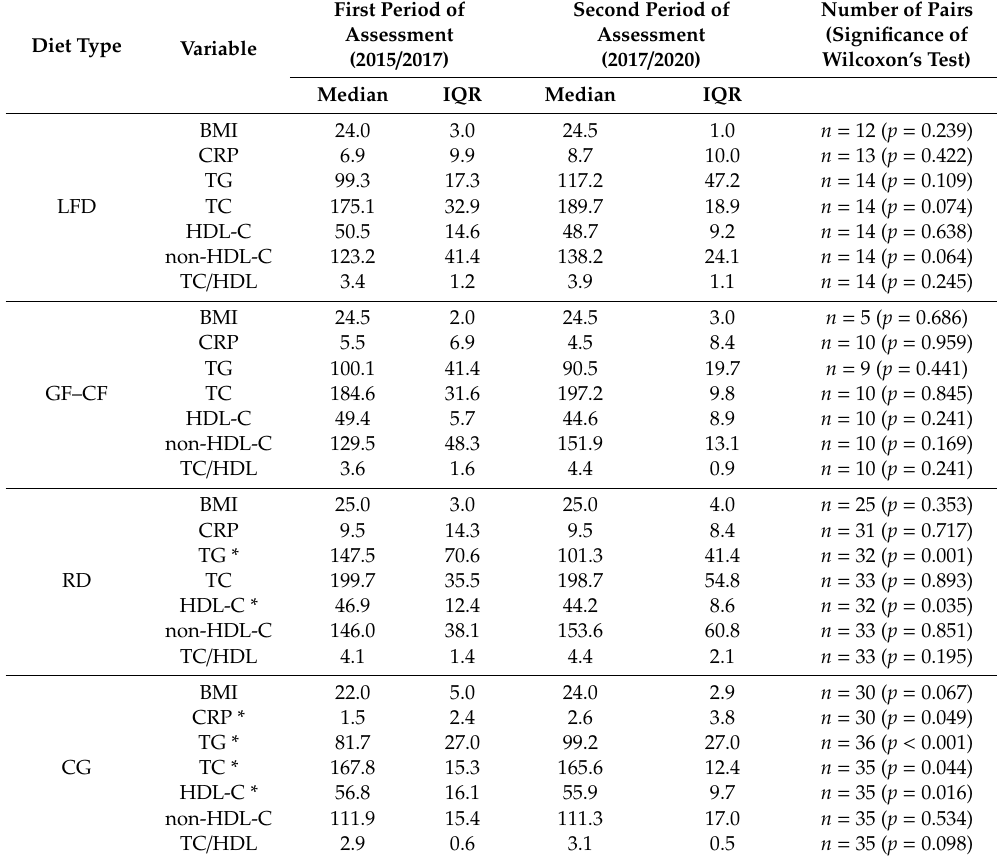
Table 4. The di ff erences over time between blood parameters according to the type of diet for ASD patients and healthy